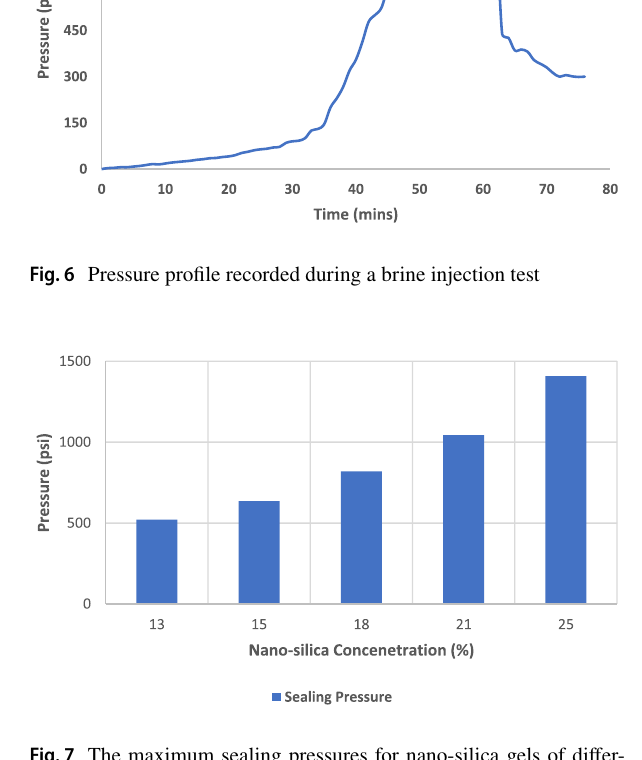
Fig. 7 The maximum sealing pressures for nano-silica gels of differ- ent concentrations